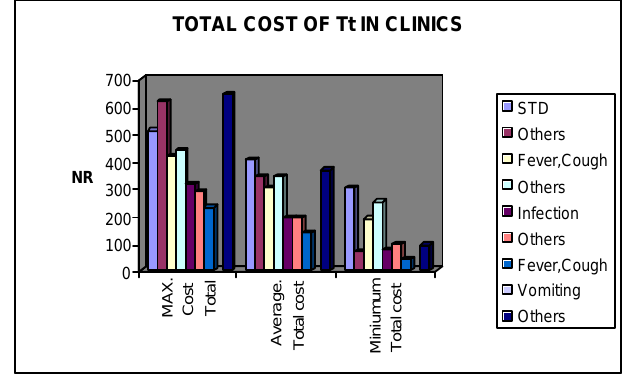
Fig. 6b : Showing pharmaco-economics of ABs treatment in all health problems in clinics (cost in